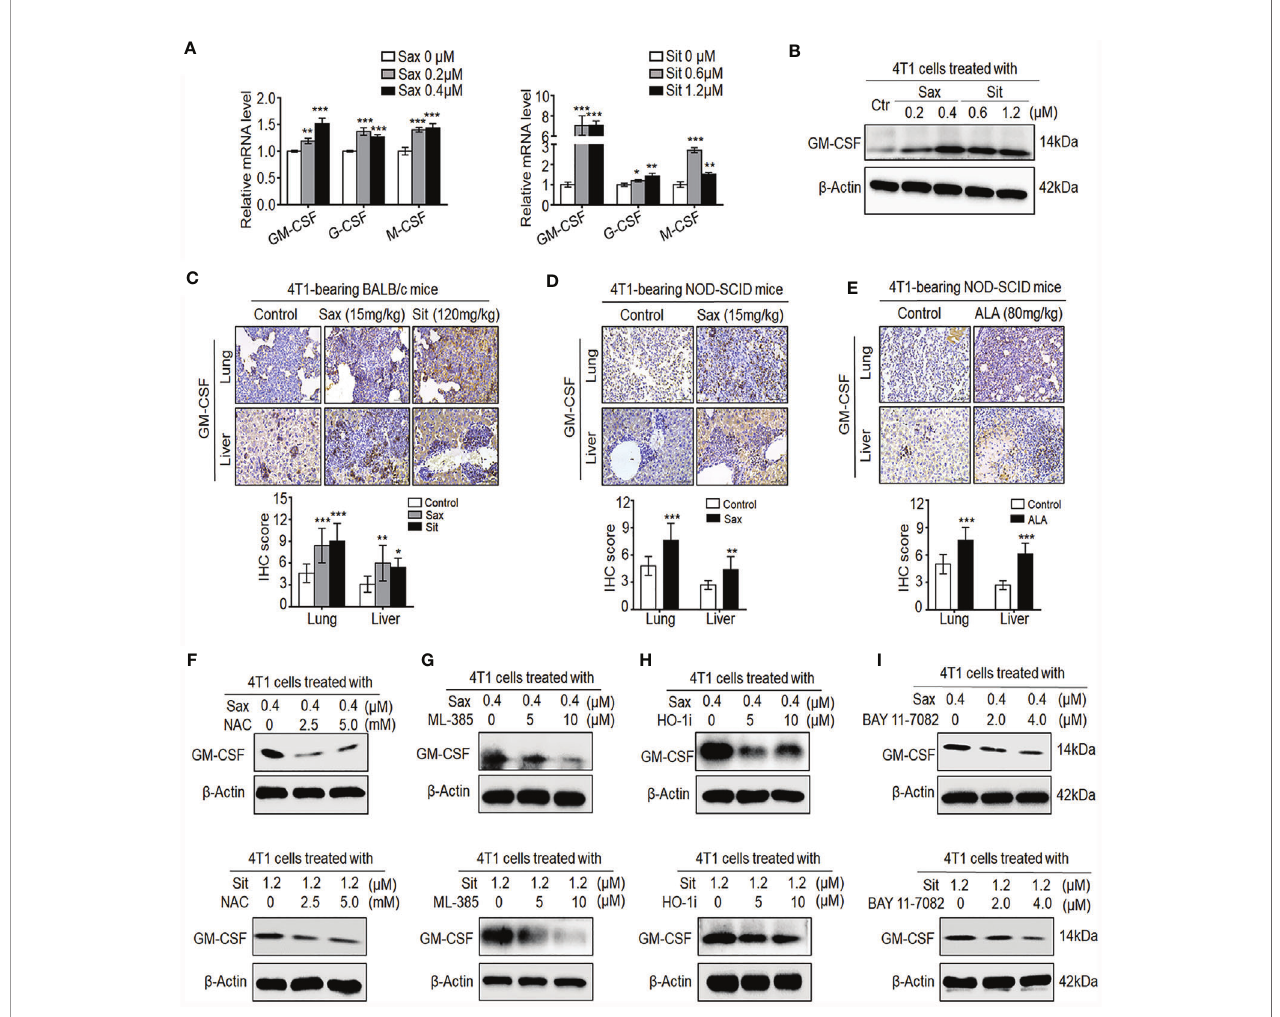
FIGURE 8 | DPP-4i promotes the secretion of GM-CSF, G-CSF, and M-CSF via ROS – NRF2 – HO-1-NF- к B axis in BC cells. (A, B) DPP-4i increases GM-CSF, G- CSF, and M-CSF secretion in 4T1 cells. 4T1 cells were treated with Sax (0, 0.2, and 0.4 m M) or Sit (0, 0.6, and 1.2 m M) for 24 h. (A) mRNA level of GM-CSF, G- CSF, and M-CSF was analyzed by qRT-PCR, and (B) GM-CSF protein was detected by Western blotting. (C) DPP-4i promotes GM-CSF secretion of 4T1 cells in vivo . 4T1-bearing BALB/c mice were treated with Sax (15 mg/kg) or Sit (120 mg/kg) via oral gavage daily. GM-CSF were detected in lung and liver metastatic tissues by IHC staining. (D, E) 4T1-bearing NOD-SCID mice were treated with Sax (15 mg/kg) via (D) oral gavage daily or ALA (80 mg/kg) via (E) intraperitoneal (i.p.) administration, and GM-CSF expression was detected in lung and liver metastatic tissues by IHC staining. (F) ROS inhibition attenuates DPP-4i-induced GM-CSF secretion. 4T1 cells were co-treated with Sax (0.4 m M) or Sit (1.2 m M) and NAC (0, 2.5, and 5 mM), respectively, and GM-CSF expression was detected by Western blotting. (G, H) Inhibition of NRF2-HO-1 abrogates DPP-4i-induced GM-CSF secretion. 4T1 cells were co-treated with Sax (0.4 m M) or Sit (1.2 m M), and (G) ML-385 (0, 5, and 10 m M) or (H) HO-1 inhibitor (0, 5, and 10 m M) respectively. Then, GM-CSF expression was detected by Western blotting. (I) NF- к B blockage abrogates DPP-4i-induced GM-CSF secretion. 4T1 cells were co-treated with Sax (0.4 m M) or Sit (1.2 m M) and BAY 11-7082 (0, 2, and 4 m M), respectively, and GM-CSF expression was detected by Western blotting. b -Actin was used as a loading control. Representative images are shown. Data are presented as mean ± SD of three independent experiments. Scale bar: 50 m m. *p < 0.05, **p < 0.01, and ***p < 0.001 between the indicated groups determined by unpaired Student ’ s t-test or the one-way analysis of variance